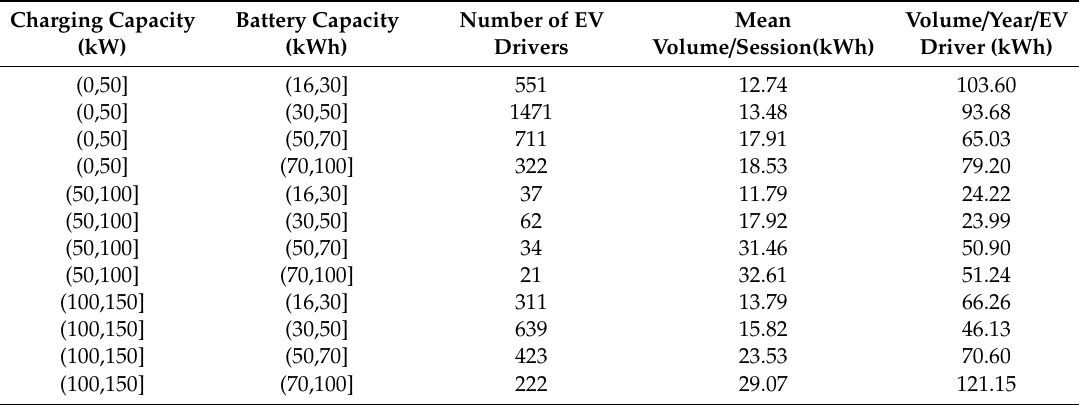
Table 4. Charging volume depending on charging and battery